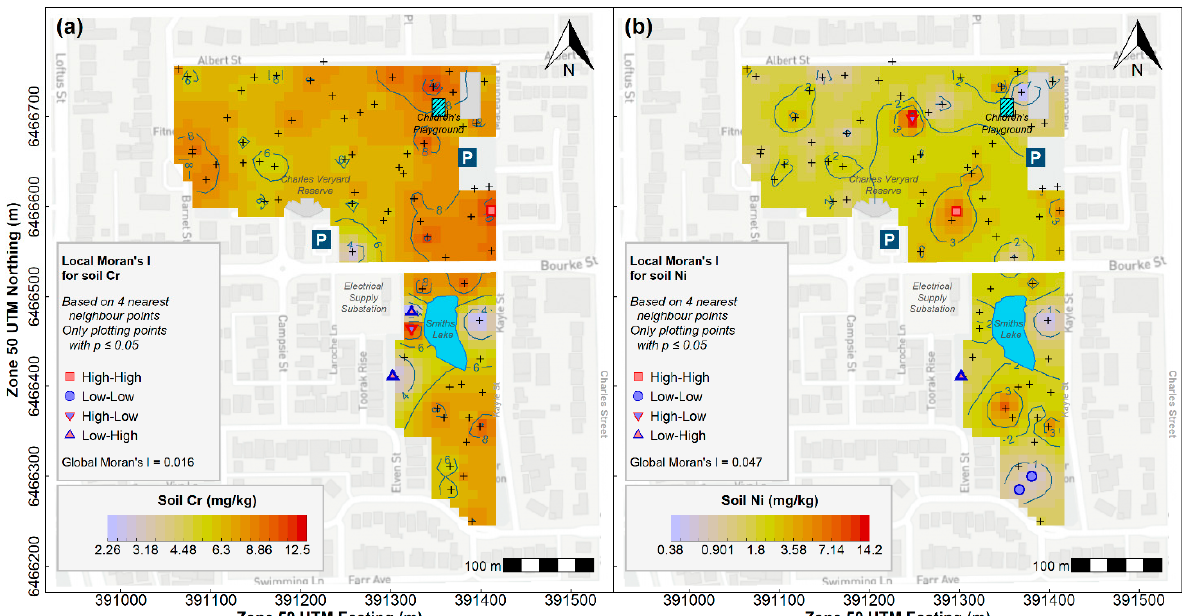
Figure 4. Spatial distributions of ( a ) Cr and ( b ) Ni in soil across Smith’s Lake and Charles Veryard Reserves, interpolated by inverse distance weighting with significant local spatial autocorrelations (Local Moran’s I ≤ 0.05) indicated with filled symbols. All sample points shown by + symbols.